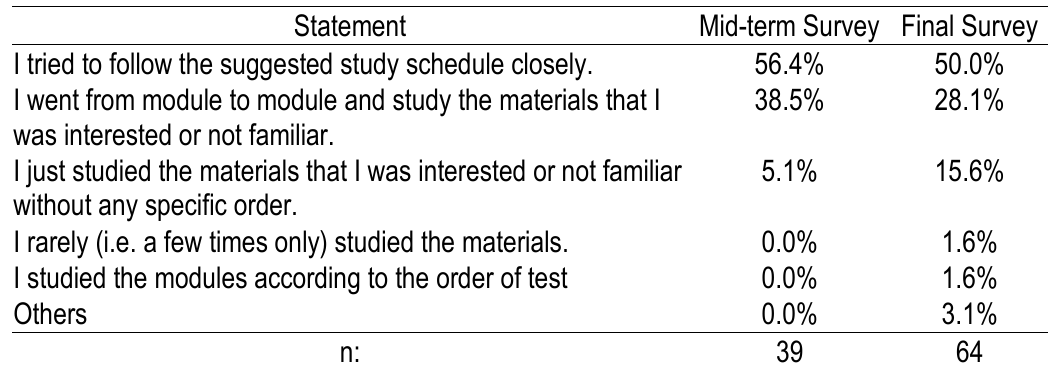
Table 4. Ways of using the